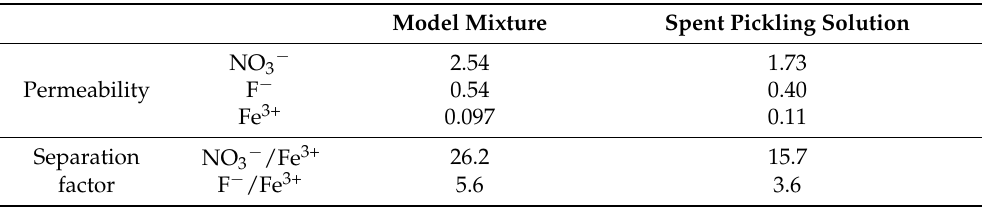
Table 4. Permeability ( P i × 10 6 m/s) and separation